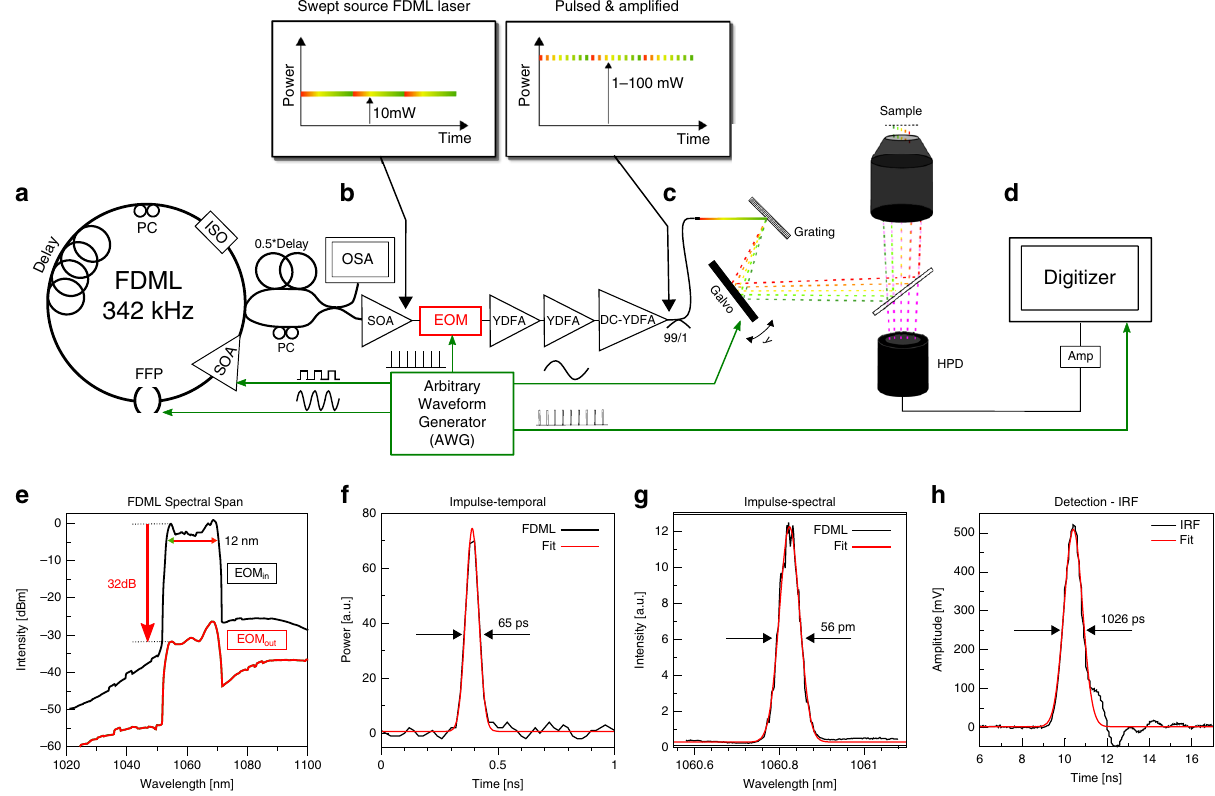
Fig. 2 Experimental Setup of the SLIDE system. a The light source is an FDML-MOPA laser 28,29 at 1060 nm (±6 nm) and 342 kHz sweep repetition